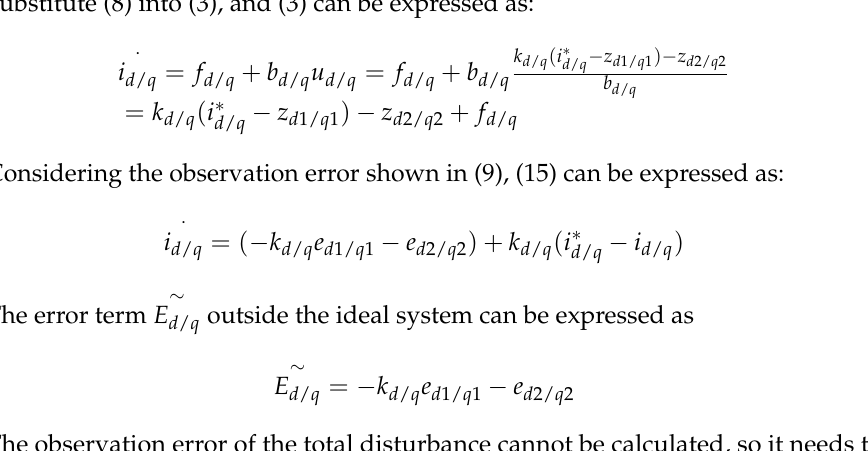
Figure 2. Bode diagram of observation error transfer function: ( a ) G e